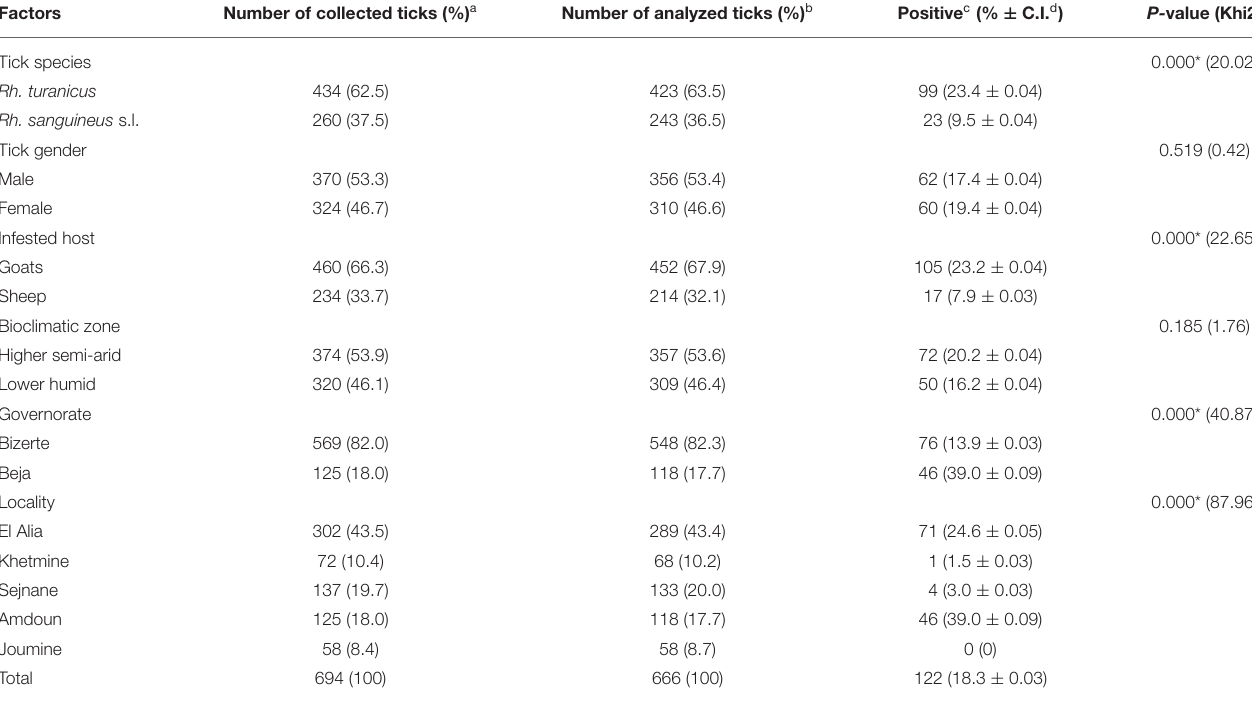
TABLE 2 | Molecular prevalences of Rickettsia spp. according to tick species, tick gender, infested host, bioclimatic zone, governorate, and locality. Factors Number of collected ticks (%) a Number of analyzed ticks (%) b Positive c (% ± C.I. d )